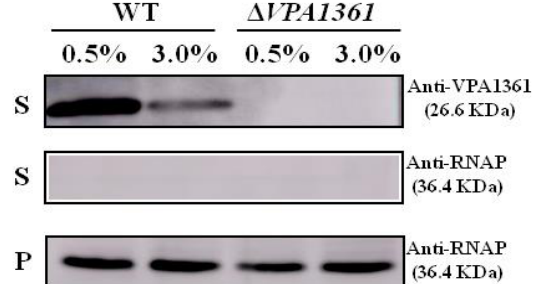
Figure 5. Low NaCl concentration induces the secretion of VPA1361. Western blotting analysis was performed to determine the secretion of VPA1361 in WT and ∆ VPA1361 in M9 medium with 0.5% or 3% NaCl. The supernatants (S) and cellular pellets (C) were collected and used for Western blotting analysis with VPA1361-specific antibodies. RNAP was used as the loading control of Western blotting.